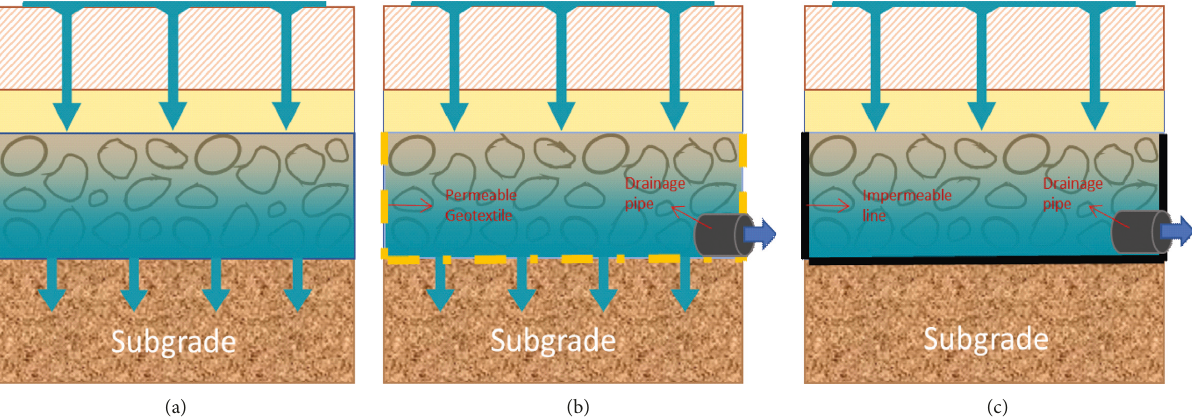
Figure 9: Typical permeable pavement sections (based on [99–101]): (a) fully permeable pavement, where water can infiltrate to subgrade; (b) half permeable pavement, with some water infiltrating to the subgrade, most is stored in the pavement structure; (c) permeable pavement with no water infiltrating to the subgrade but is stored in the pavement